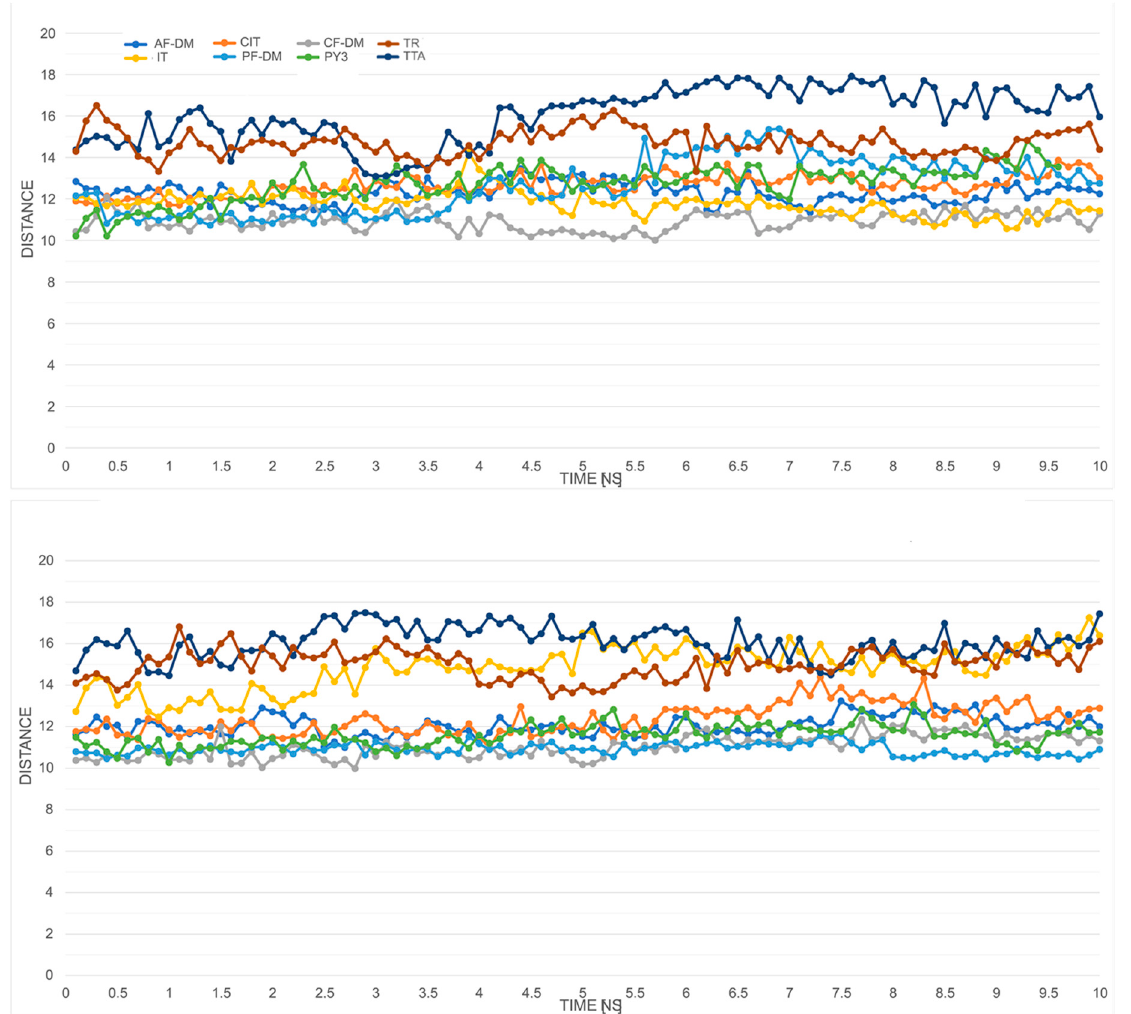
Figure 5. The changes in average distance measurements between C α atoms of the last five cytoplasmic residues in TM3 (from Y3.51 to V(124)) and TM6 (from K6.30 to I6.34) for apo/unbound ( upper panel ) and CB148-complexed ( lower panel ) protein models. For colored graphs, please refer to the online version of this paper.